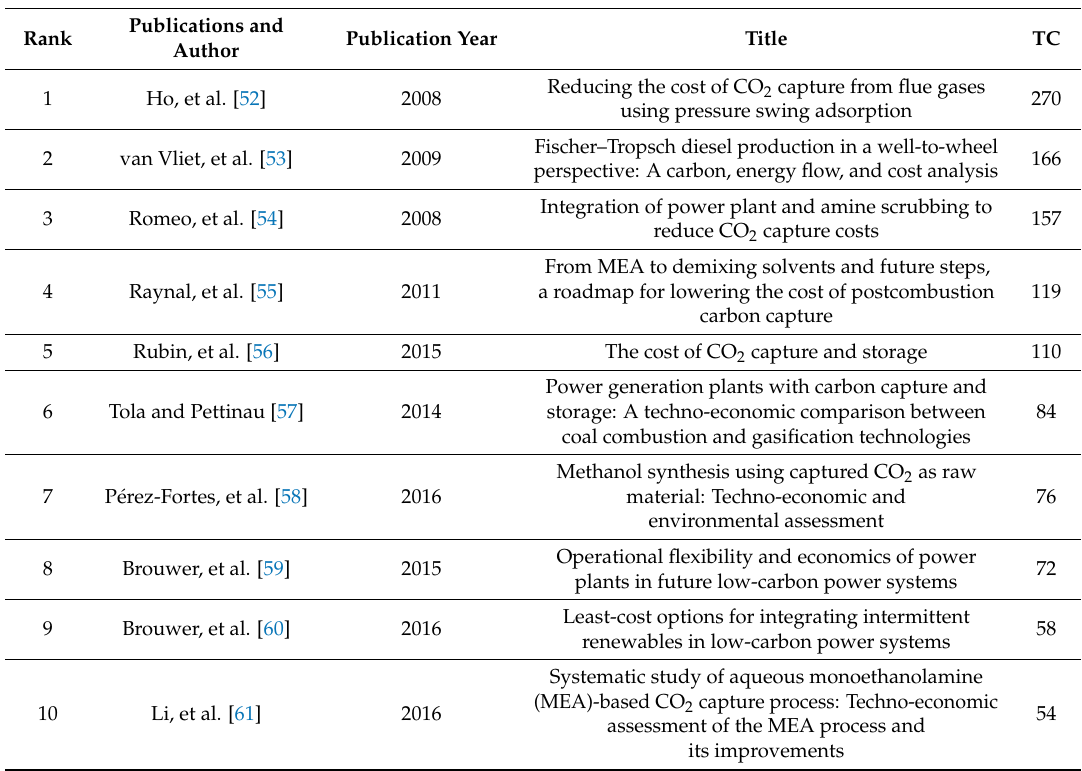
Table 5. Top 10 highly cited